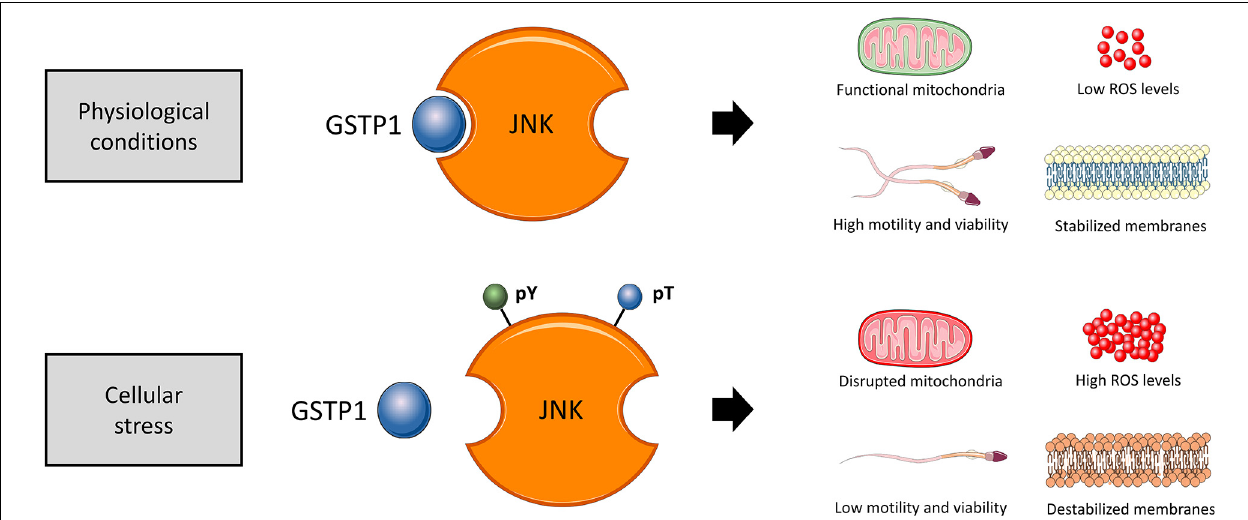
FIGURE 11 | Proposed diagram of the function of the GSTP1–JNK heterocomplex under physiological conditions and cellular stress in sperm cells. In physiological conditions, the GSTP1–JNK heterocomplex prevents JNK activation, maintaining sperm viability, motility, mitochondrial activity, and plasma membrane stability and increased superoxide levels. On the other hand, under cellular stress conditions, the GSTP1–JNK heterocomplex is dissociated, and thus, JNK is activated by tyrosine (pY) and threonine (pT) phosphorylation. The activation of JNK decreases sperm viability and motility, disrupts mitochondrial activity, causes plasma membrane destabilization, and increases intracellular superoxide levels.